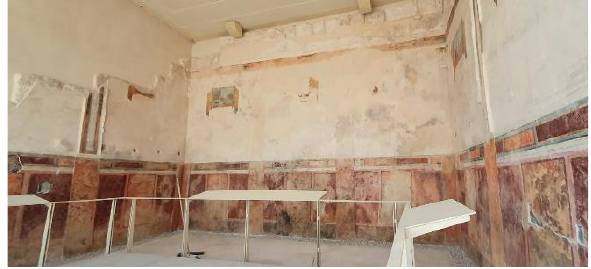
Figure 4. The Royal Box - present state